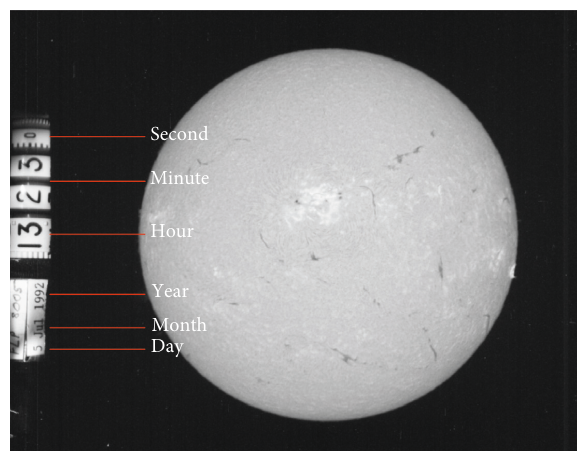
Figure 1: Full-disk chromosphere image obtained in Halpha by NSO. The time stamp is on the left side of the image, and the full- disk chromosphere image in the middle.